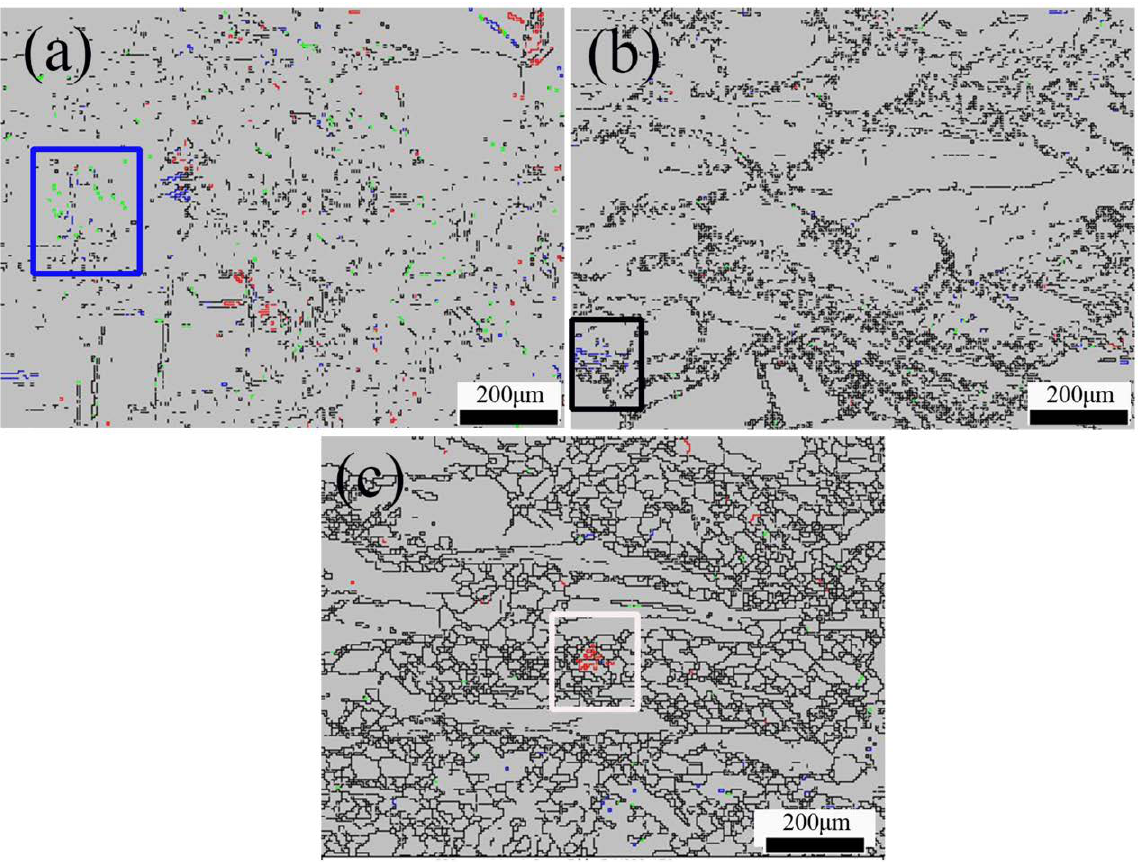
Figure 13. The grain boundary maps of samples deformed at ( a ) 200 °C/0.01 s − 1 , ( b ) 300 °C/0.01 s − 1 and ( c ) 400 °C/0.01 s − 1 .